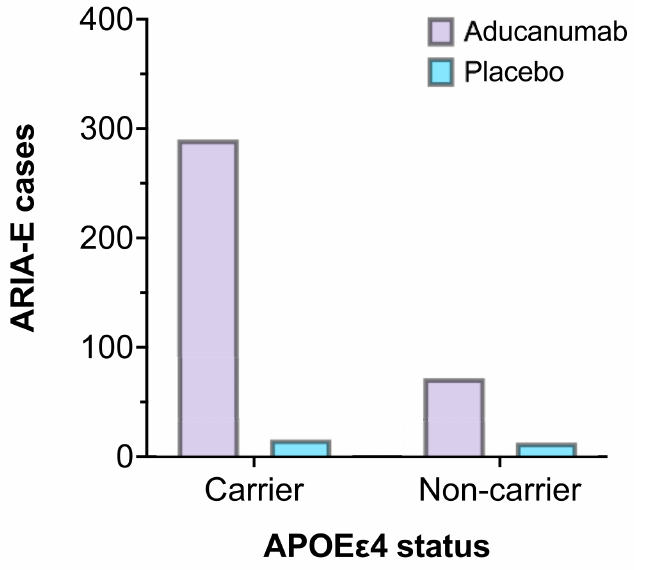
Figure 4. The number of ARIA-E cases by APOE ε 4 carrier status in EMERGE and ENGAGE (adu- canumab 10 mg/kg, n = 362 vs. placebo, n = 29)